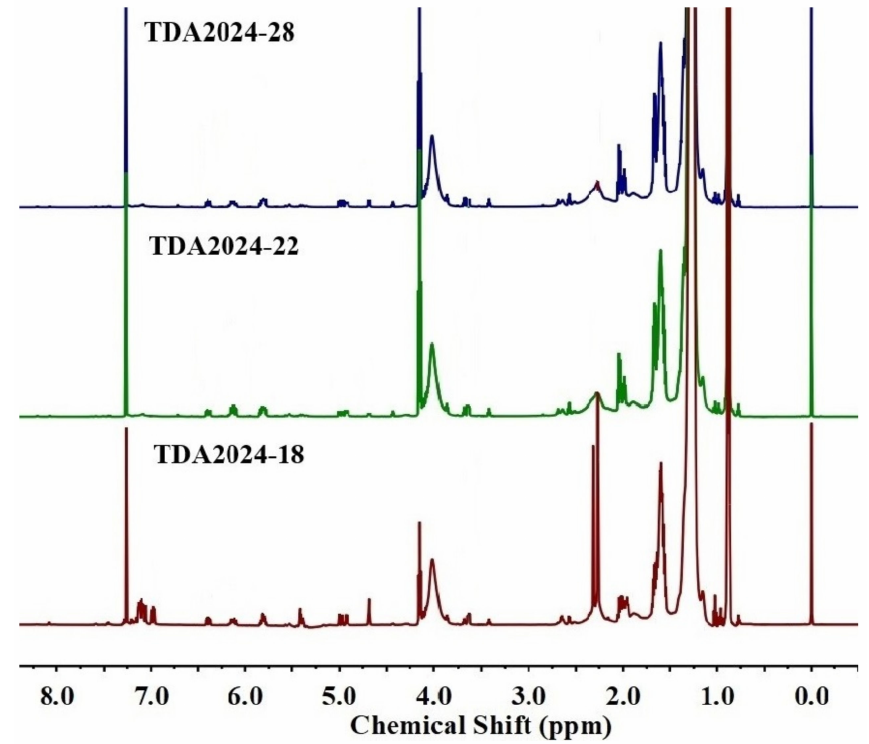
Figure 3. 1 H NMR spectra of the α -olefins/ultra-long alkyl acrylate bipolymers.